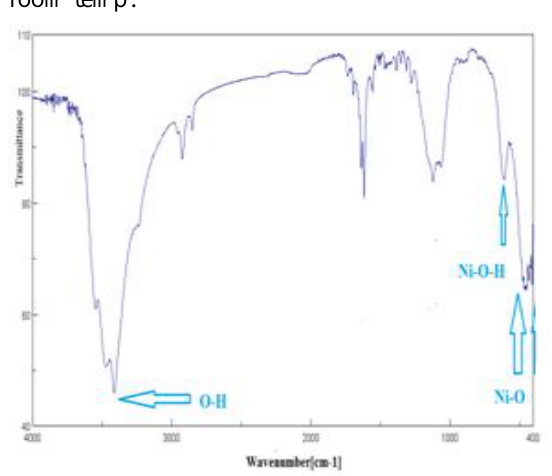
Fig. 9. FTIR spectrum of the NiO nanoparticle before Calcination at room temp.